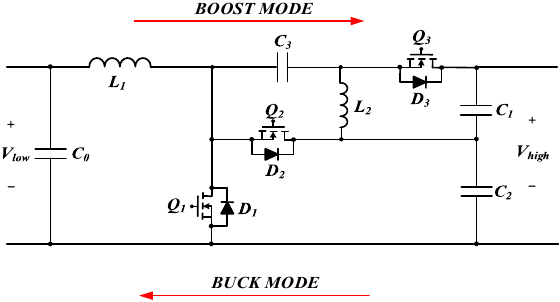
Figure 1. Proposed converter I (Boost + Sepic).